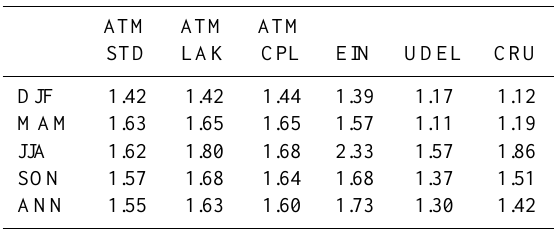
Table 1. Seasonal and annual basin averaged (Volga, Kura and Ural) precipitation (mmday − 1 ) for the period 1999–2008 in the three RCM simulations (ATM.STD, ATM.LAK and ATM.CPL) and the different observation datasets. EIN is ERA Interim Re-analysis data, which is used to drive RCM.